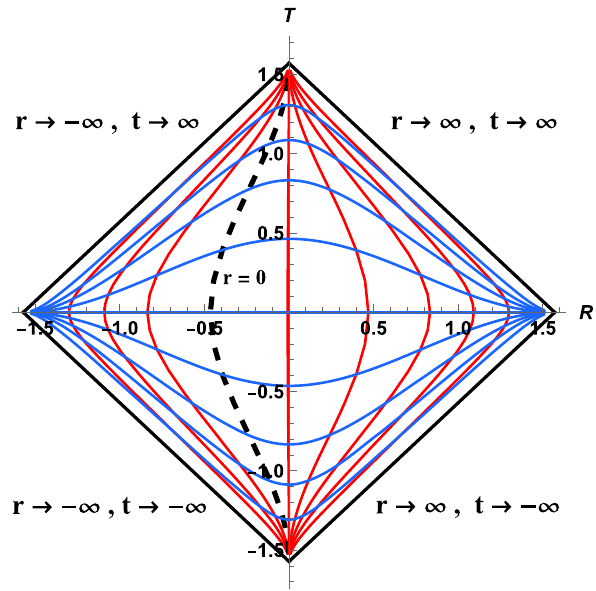
Fig. 1 Penrose diagram of rotating naked singularity